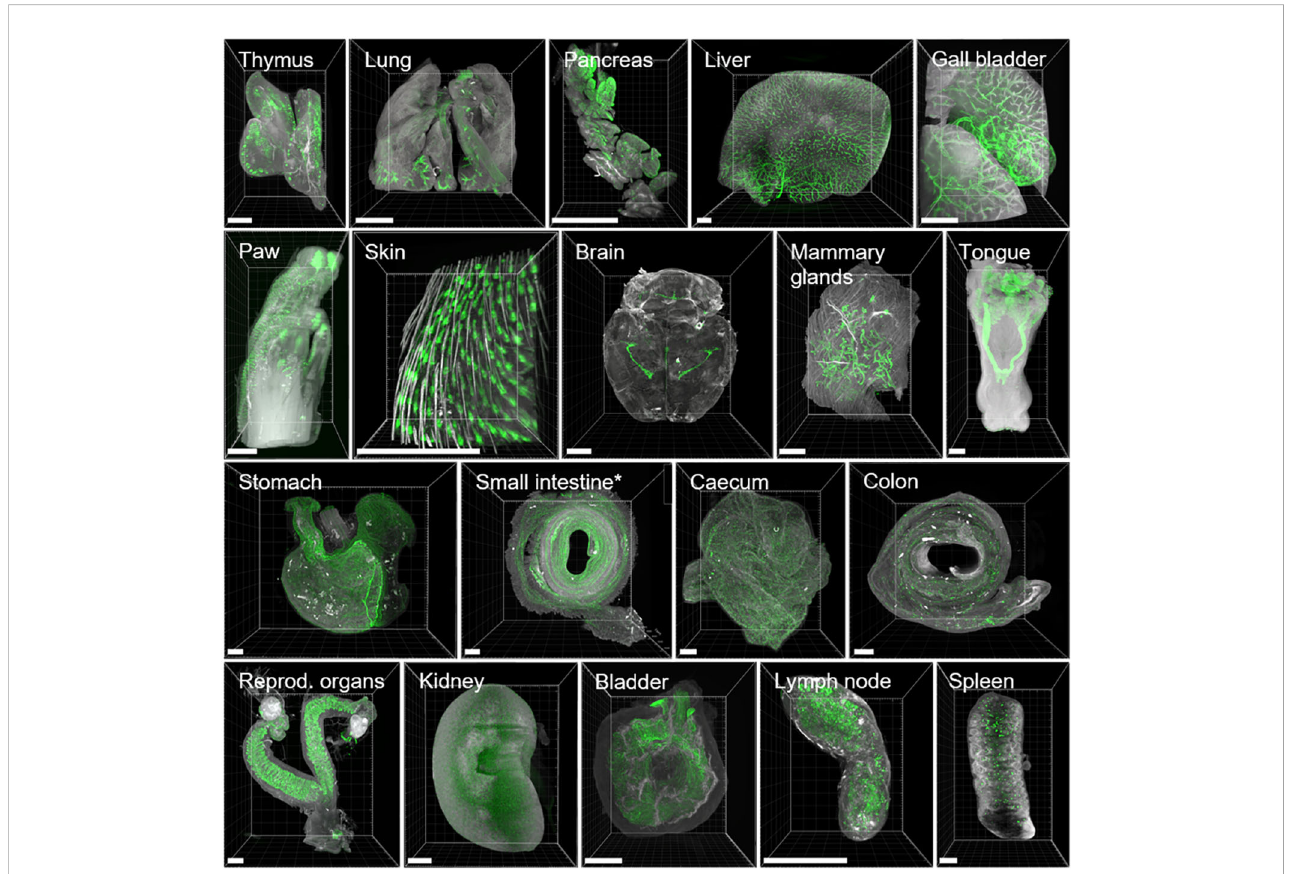
FIGURE 4 3D renderings of LSFM images show highly heterogeneous binding of anti-EpCAM antibody (G8.8R) between and within organs. EpCAM stainings (G8.8R in green) and tissue anatomy revealed by tissue auto fl uorescence (grey) in maximum intensity projections (MIPs) of selected positive tissues. EpCAM binding was detected at (but not limited to) previously published sites of EpCAM expression (91). * Only the fi rst of three segments of the small intestine depicted (corresponding to duodenum and proximal jejunum). Scale bars = 1000 m